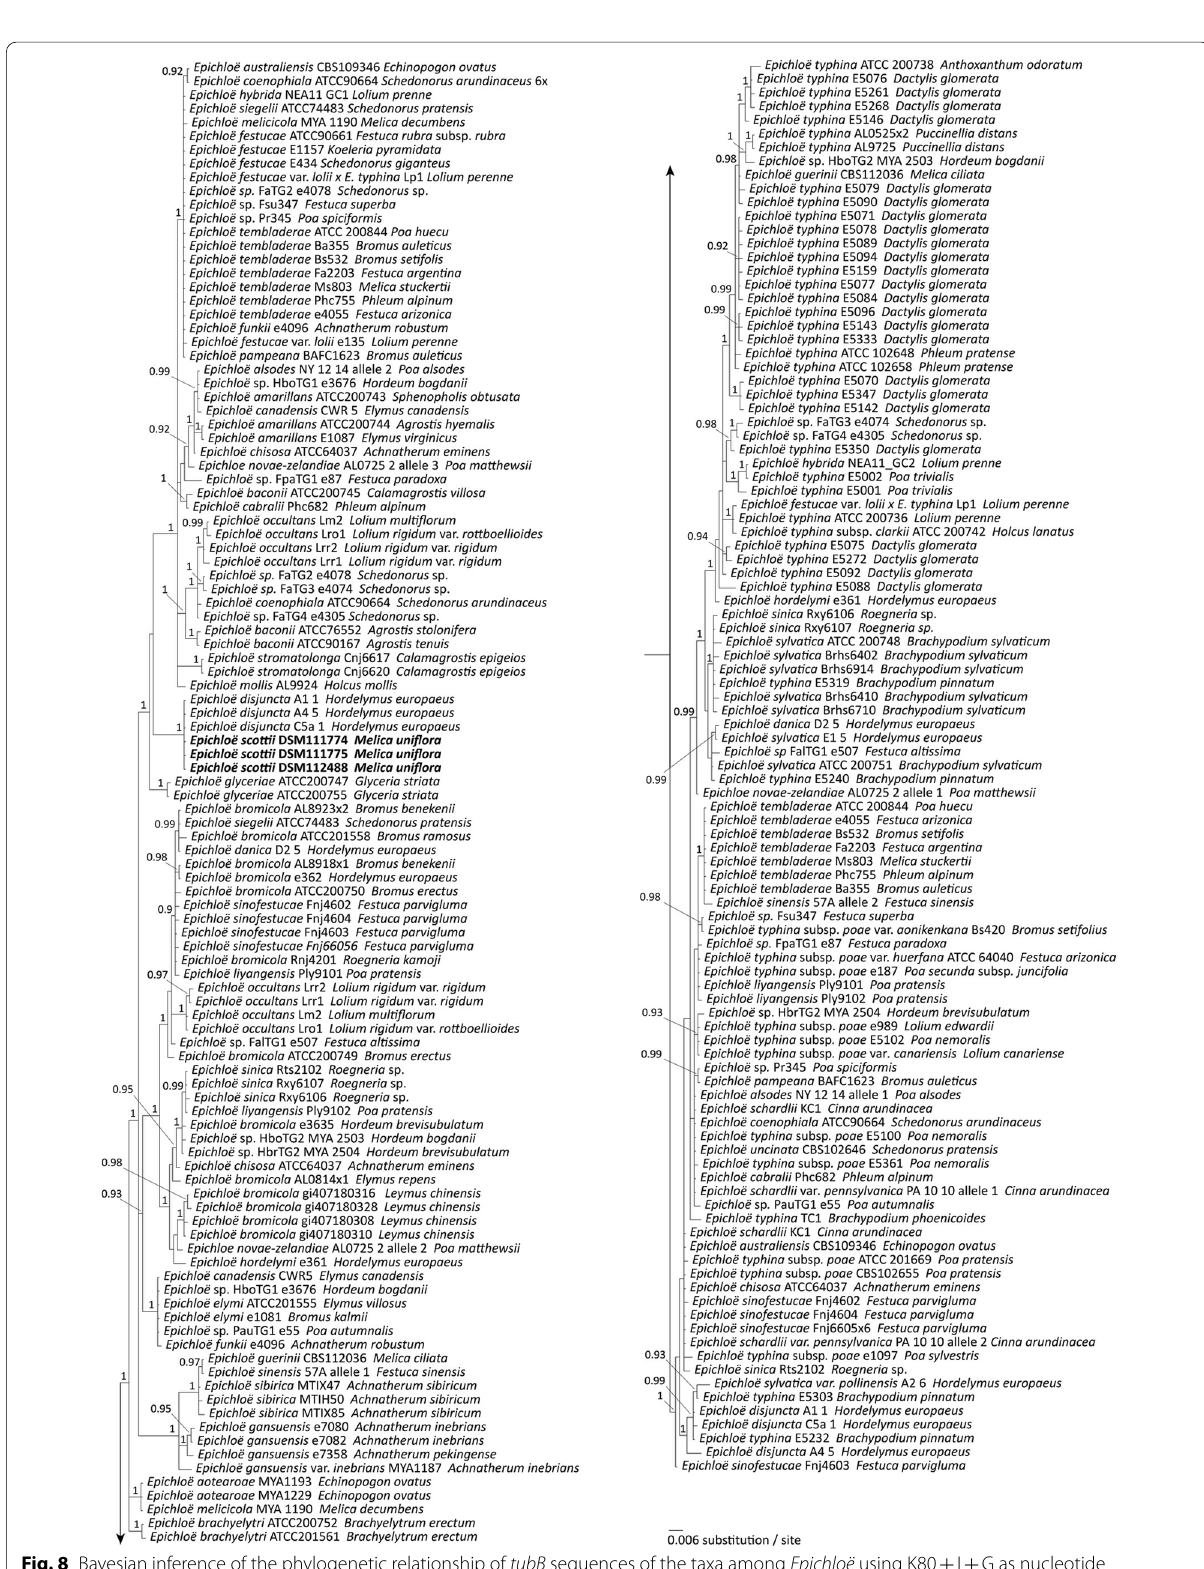
Fig. 8 Bayesian inference of the phylogenetic relationship of tubB sequences of the taxa among Epichloë using K80 substitution model. Numbers above nodes are estimates of a posteriori probability (BIpp, rooted as midpoint. Host species are provided after each